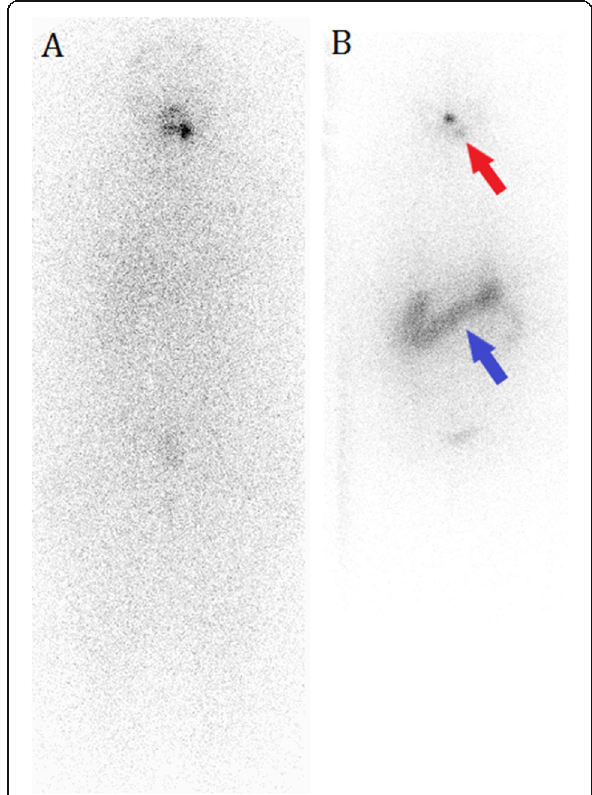
Fig. 1 Whole-body scan by therapeutic RAI ( A ) and diagnostic RAI ( B ): Normal physiological distribution of the radioactive iodine including physiological uptake in the bowel (blue arrow) and salivary gland (red arrow), with no concerning radioactive iodine-avid pathologic uptake